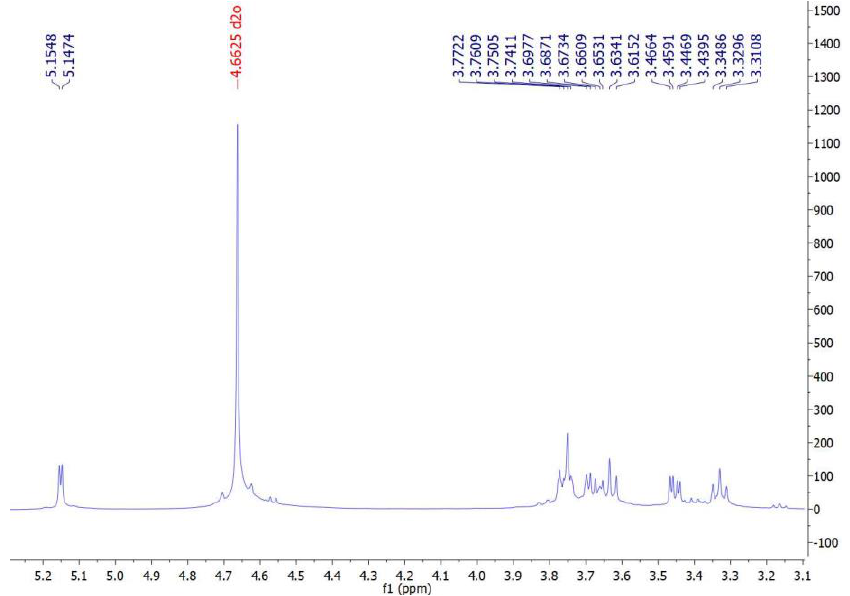
Figure 4. 1 H NMR spectrum of a commercial ALG in D 2 O and its characteristic signals.